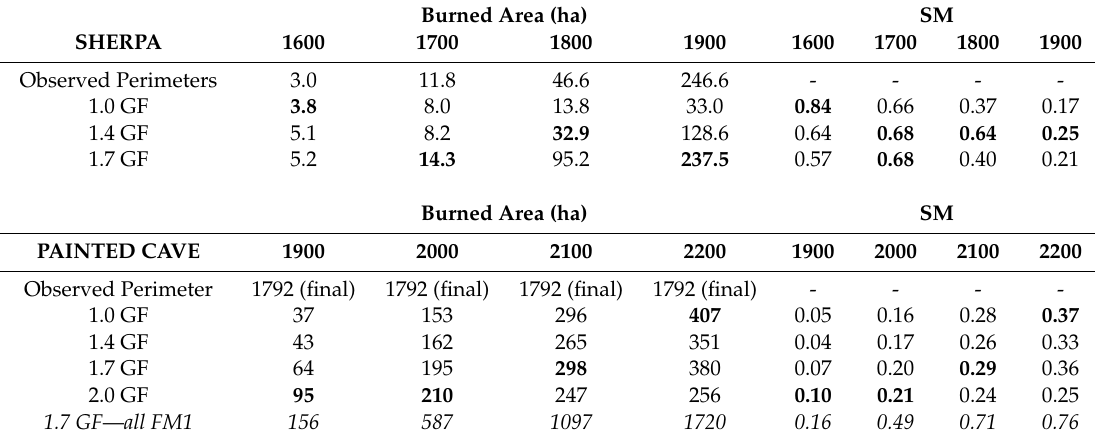
Table4. QuantitativemetricsfortheSherpa(top)andPaintedCave(bottom)simulations. Thesimulation with the burned area closest to observed and the highest SM value at each time is in bold. The all-FM1 simulation was assessed separately. Burned Area (ha) SM SHERPA 1600 Observed